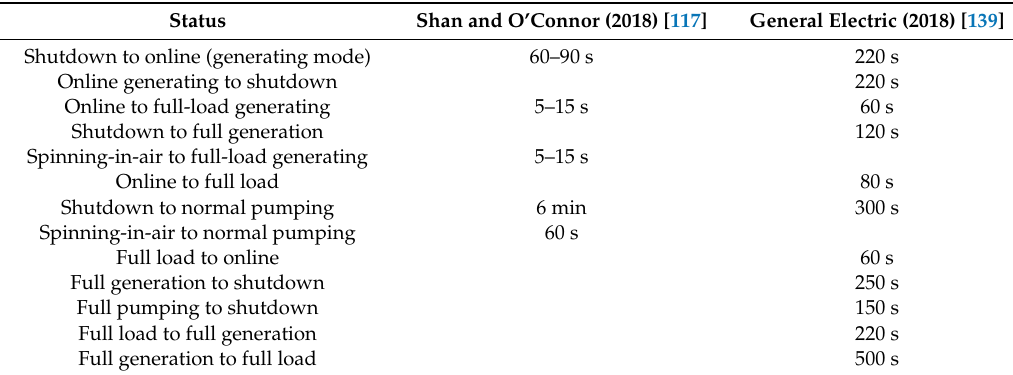
Table 26. Ramping ability of